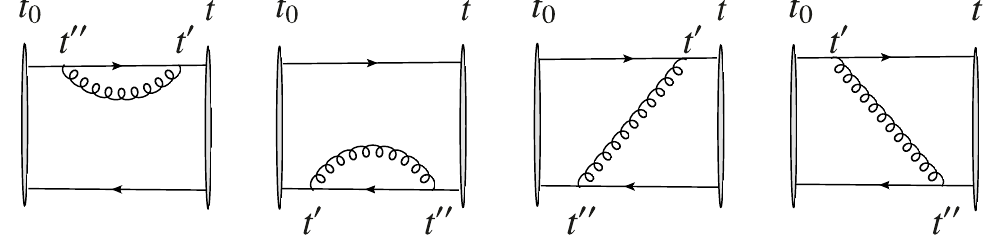
Figure 3 . These diagrams are in one-to-one correspondence with the terms in the last three lines of the right-hand side of eq. (2.13) for the single particle density matrix D I the corresponding upper and lower parts of the Schwinger-Keldysh contour. The explicit expression that this diagram represents